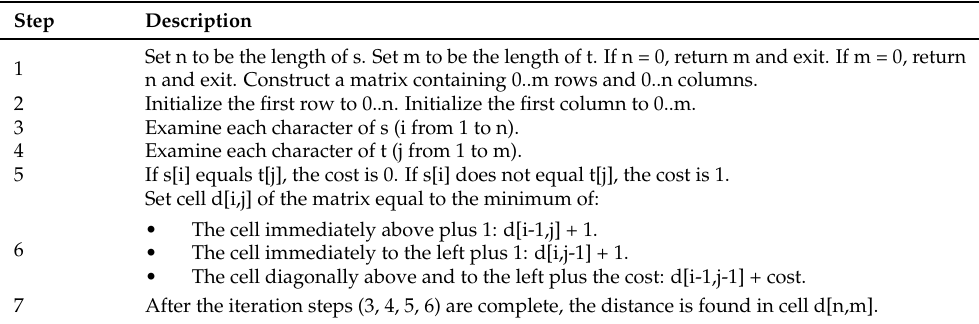
Table 1. Levenshtein distance